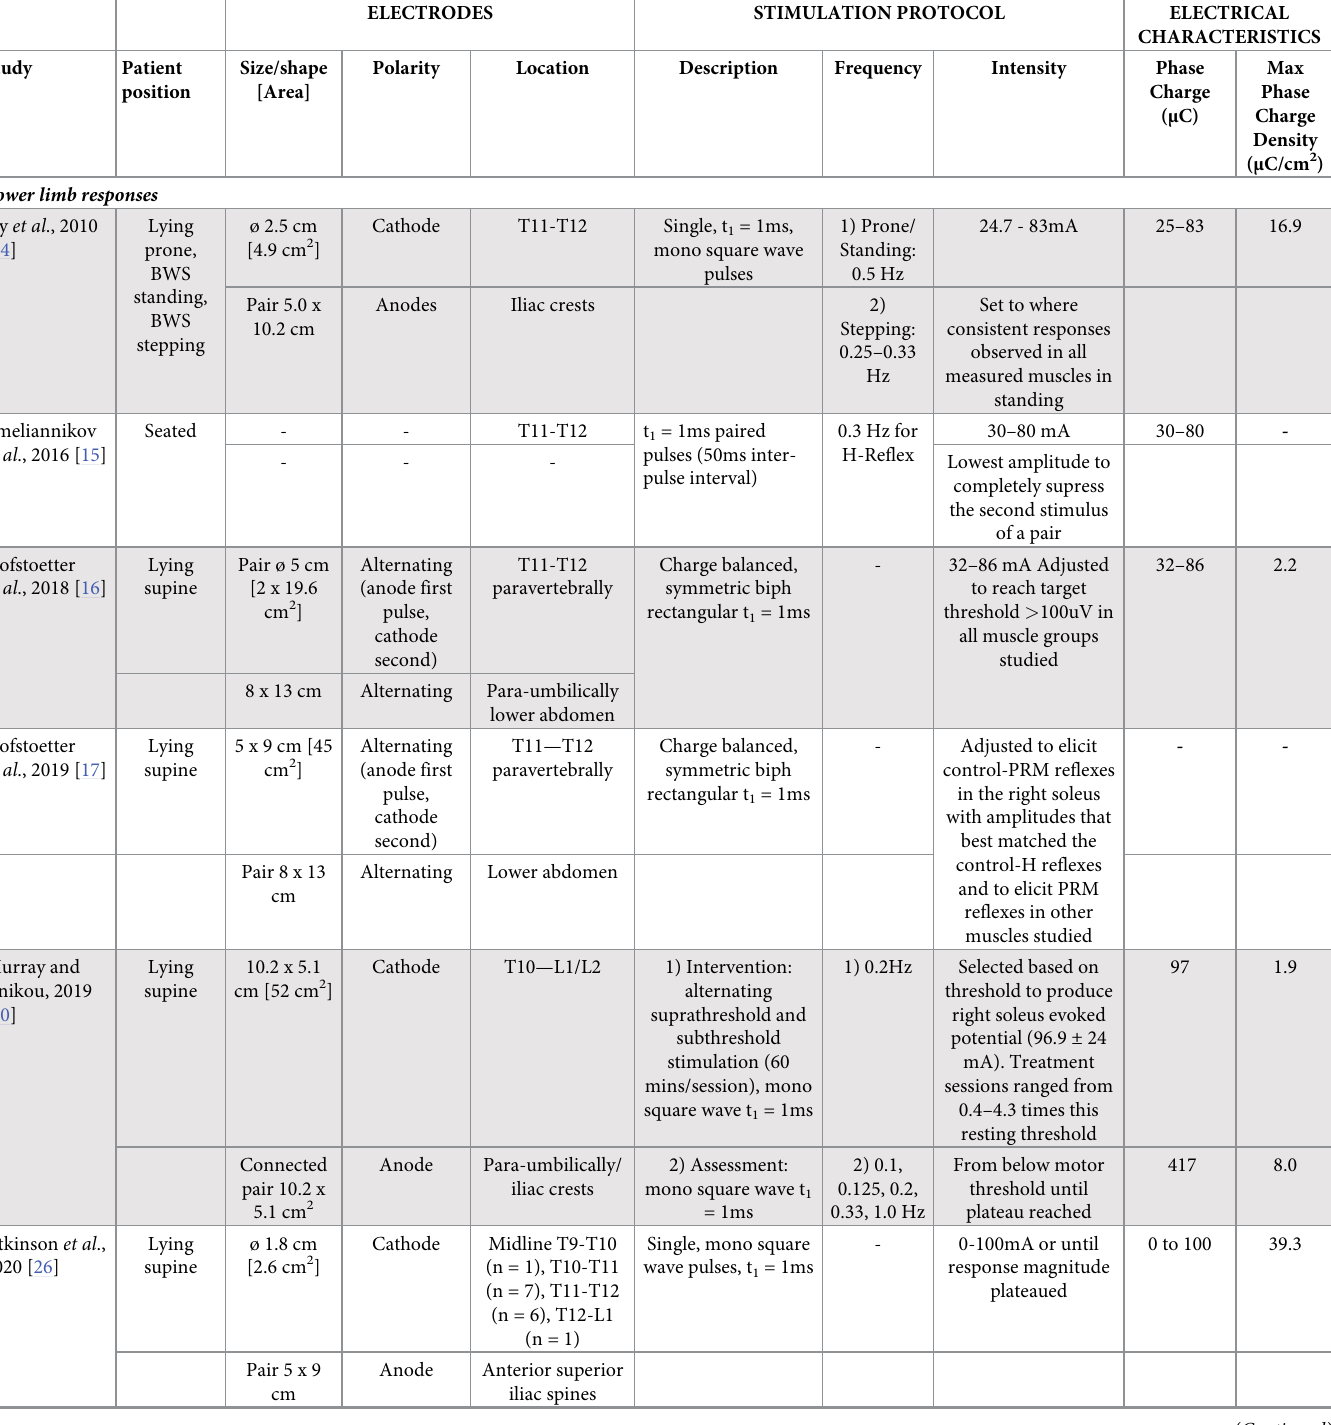
Table 6. Parameters selected by neurophysiological assessments investigating the effects of tSCS on spinal cord functioning in individuals with SCI. Stimulation parameters selected by studies carrying out neurophysiological assessments into the properties of spinal cord stimulation with SCI